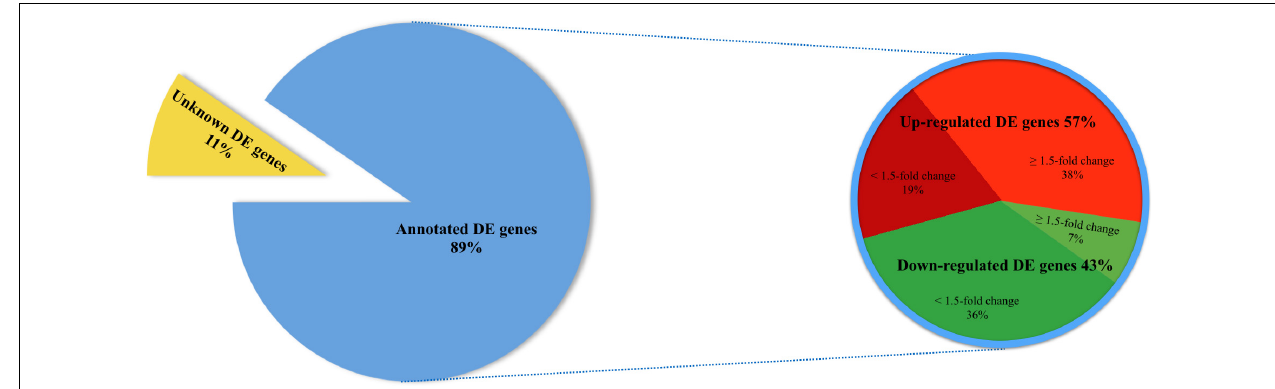
FIGURE 2 | Pie chart depicting a total of 922 differentially expressed (DE) genes ( P < 0.01) in liver of FE-divergent pigs and a percentage of annotated up- and down-regulated genes in high-FE pigs. The most up-regulated gene was PON3 (fold change = 10.08) and the most down-regulated gene was CCNT2 (fold change = − 5.40) in high FE pigs.